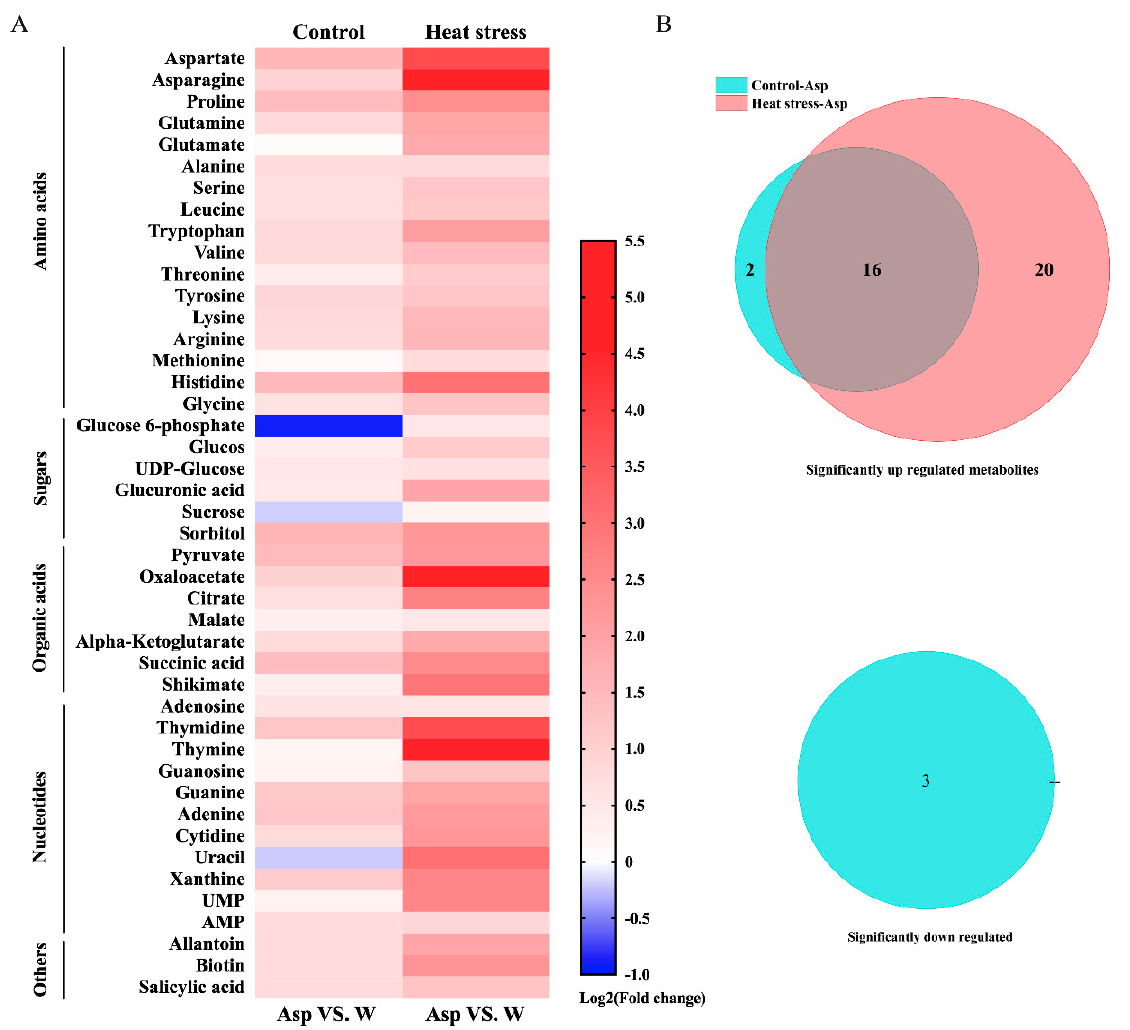
Figure 4. Heat map showing fold-changes for metabolites responsive to aspartate (Asp, 2 mM) with increases (up-regulation showing in red bars) or decreases (down-regulation showing in blue bars) in metabolite content in plants due to Asp treatment in comparison to metabolite content in the water- treated plants of perennial ryegrass under control temperature and heat stress ( A ). Venn diagram analysis demonstrating the number of significant up-regulated and down-regulated metabolites by Asp in perennial ryegrass under control temperature and heat stress ( B